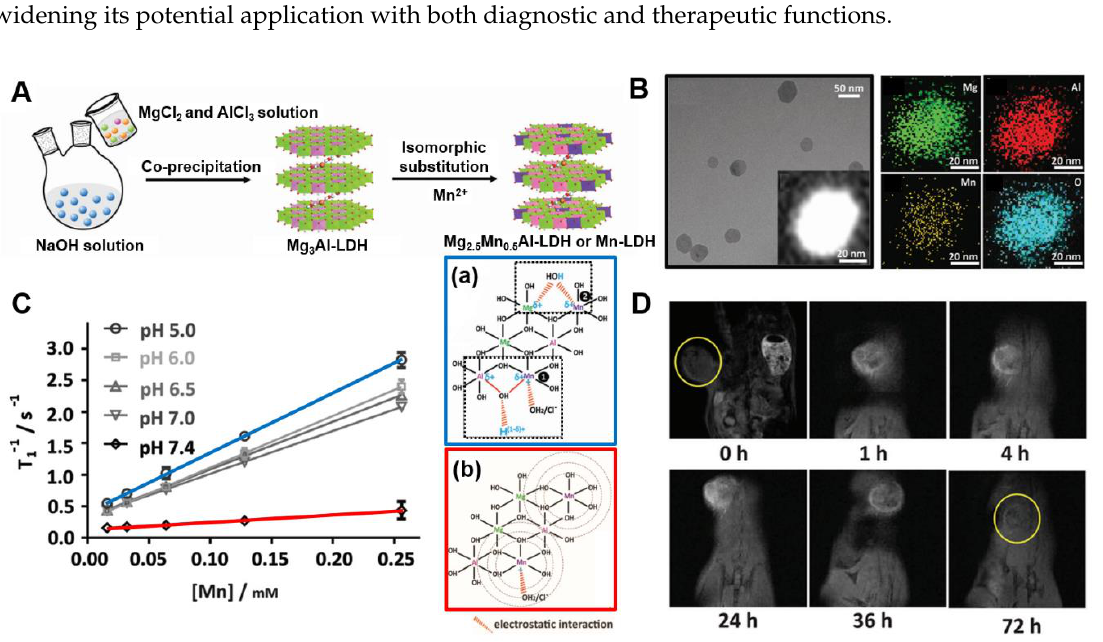
Figure 5. ( A ) Schematic illustration of synthetic procedure, ( B ) TEM image, STEM image and the corresponding element mapping of Mn-LDH nanoparticles, ( C ) Plot of T-1 versus Mn concentration of Mn-LDH nanoparticles after co-incubation with different pH buffer solution at 37 °C for 4 h and 2D atomic structure models of Mn-LDH dispersed in pH 5.0 ( a ) and pH 7.4 ( b ) buffer, ( D ) in vivo MR imaging in the melanoma tumor-bearing mouse after intravenous injection of BSA/Mn-LDH nanomaterial within 72 h, from [26], with permission from WILEY-VCH Verlag GmbH & Co. KGaA, 2017.